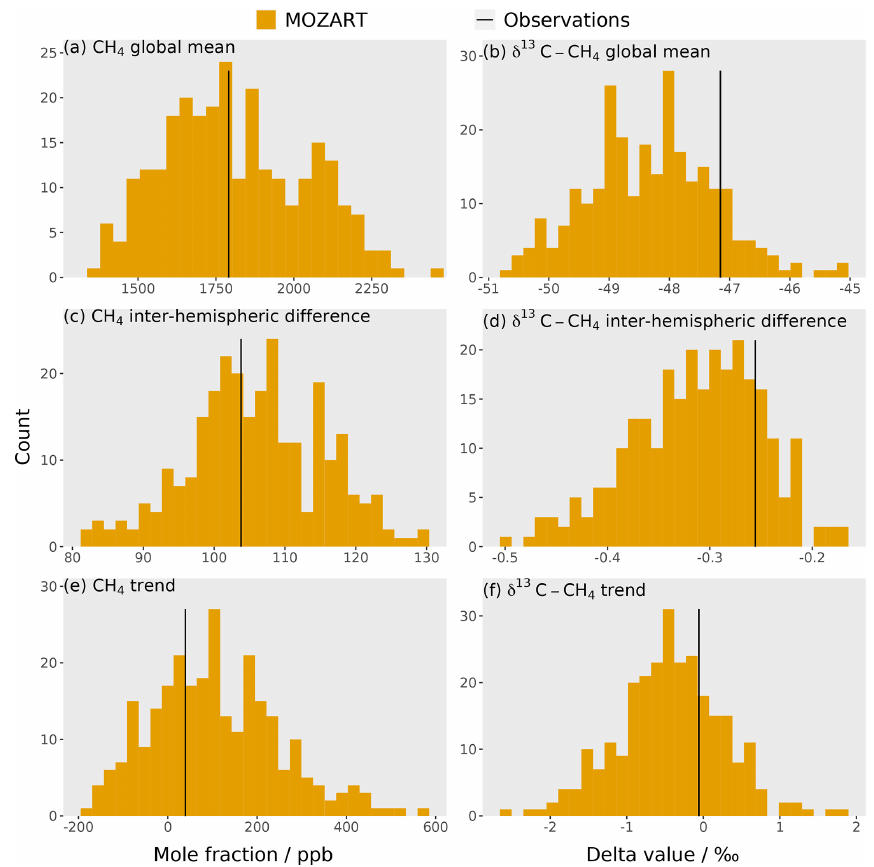
Figure 4. Histograms of the 270 3D CTM training simulations for six outputs: (a) mole fraction global mean, (b) δ 13 C–CH 4 global mean, (c) mole fraction inter-hemispheric difference, (d) δ 13 C–CH 4 inter-hemispheric difference, (e) mole fraction trend, and (f) δ 13 C–CH 4 trend. The black line is the corresponding value for the NOAA and INSTAAR atmospheric observations (Sect. 2.3), which are hemispheric averages (derived from a slightly different subset of measurement stations to those used in this work) presented in Rigby et al.